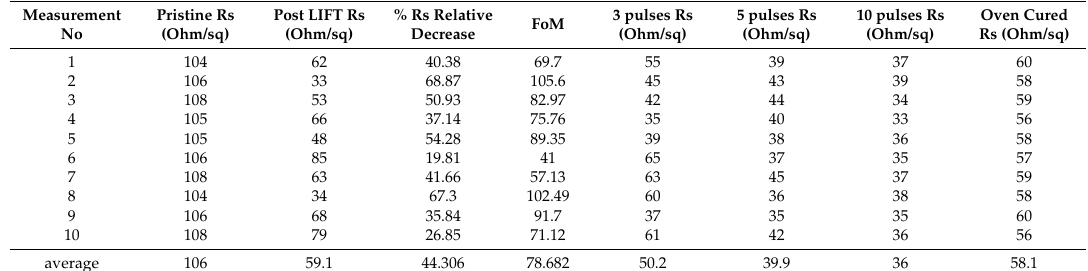
Table 2. Electrical measurement for Sheet Resistance and Figure of Merit